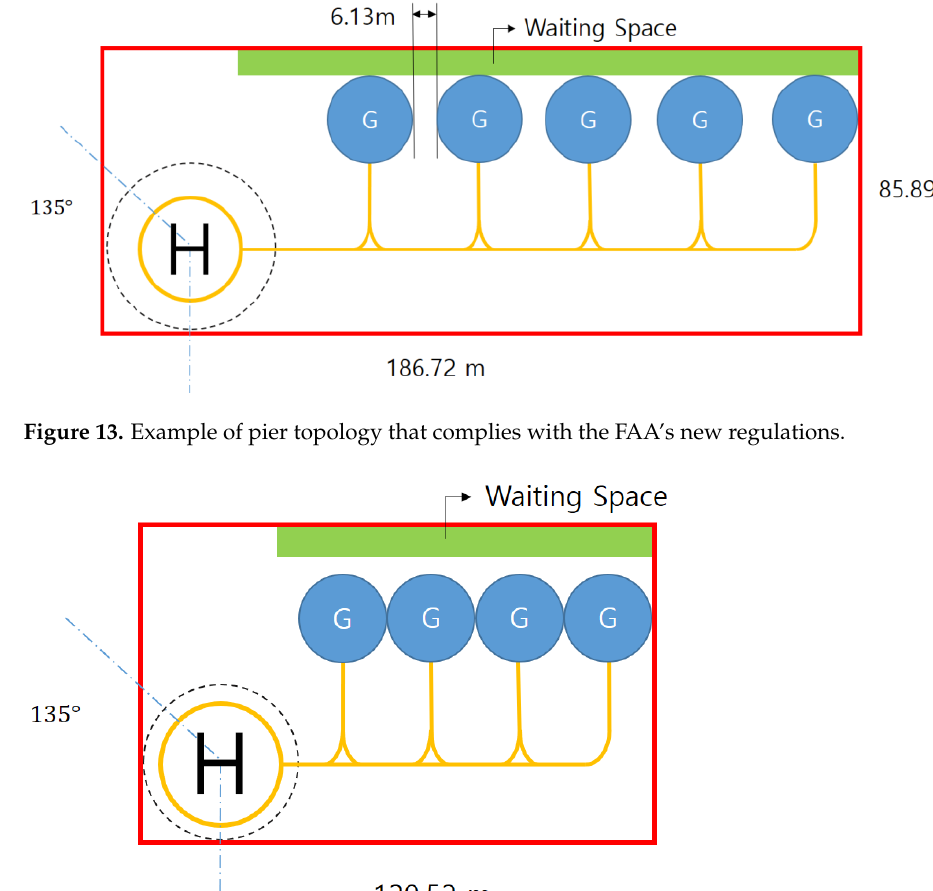
10 of 33 Figure 12. Example of satellite topology that complies with the EASA’s new regulation. The pier topology has an intermediate rectangular form between a linear topology and a satellite topology. This layout separates the area of the TLOF and the gate to make the takeoff and landing angles at the TLOF pad wider, and a large number of gates can increase the gate utilization. However, since this arrangement shares one taxiway, aircraft